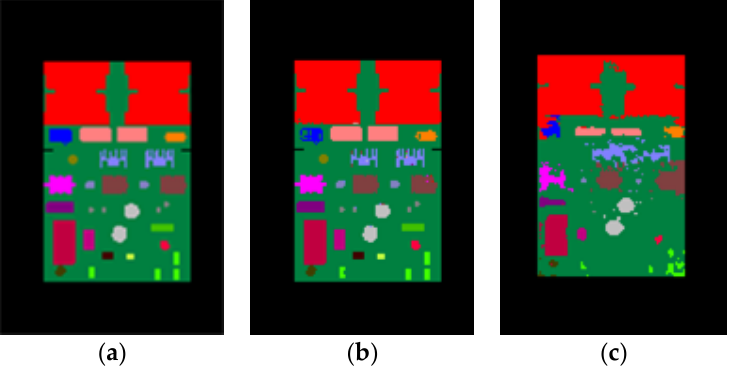
Figure 10. Component type labels used as the output labels. ( a ) The ground truth color-labeled image. ( b ) The results for the synthetic depth image. ( c ) The results for the real depth image.